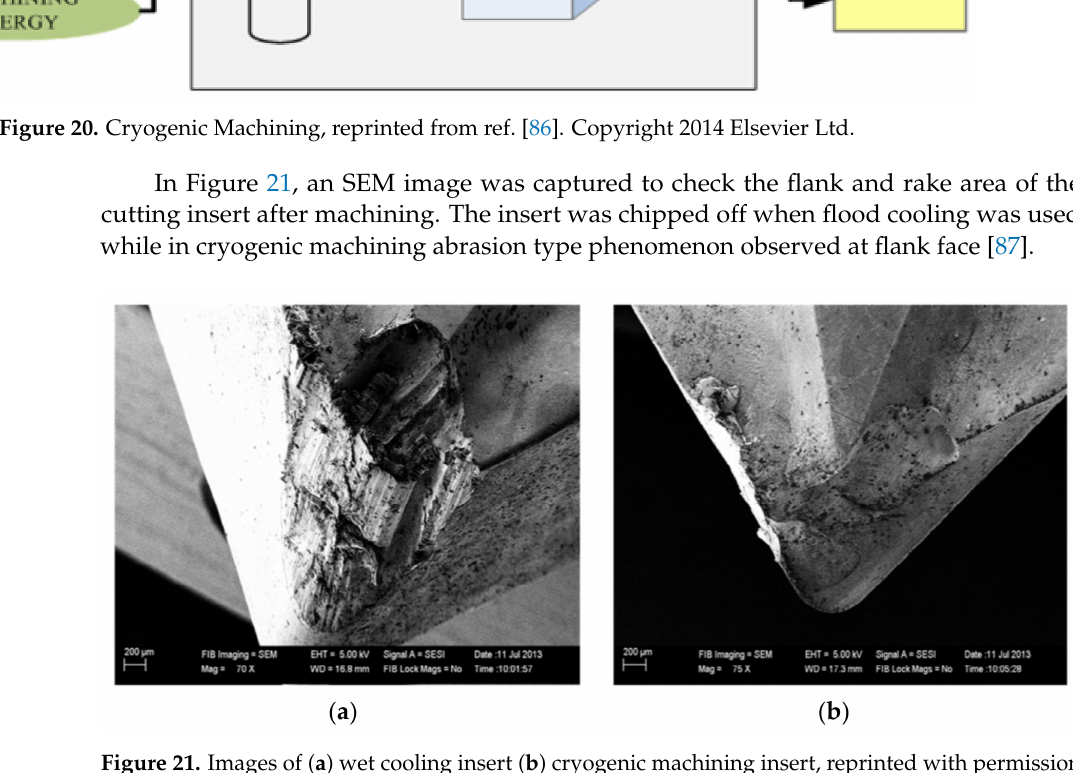
Figure 21. Images of ( a ) wet cooling insert ( b ) cryogenic machining insert, reprinted with permission from ref. [87]. Copyright 2017 Elsevier